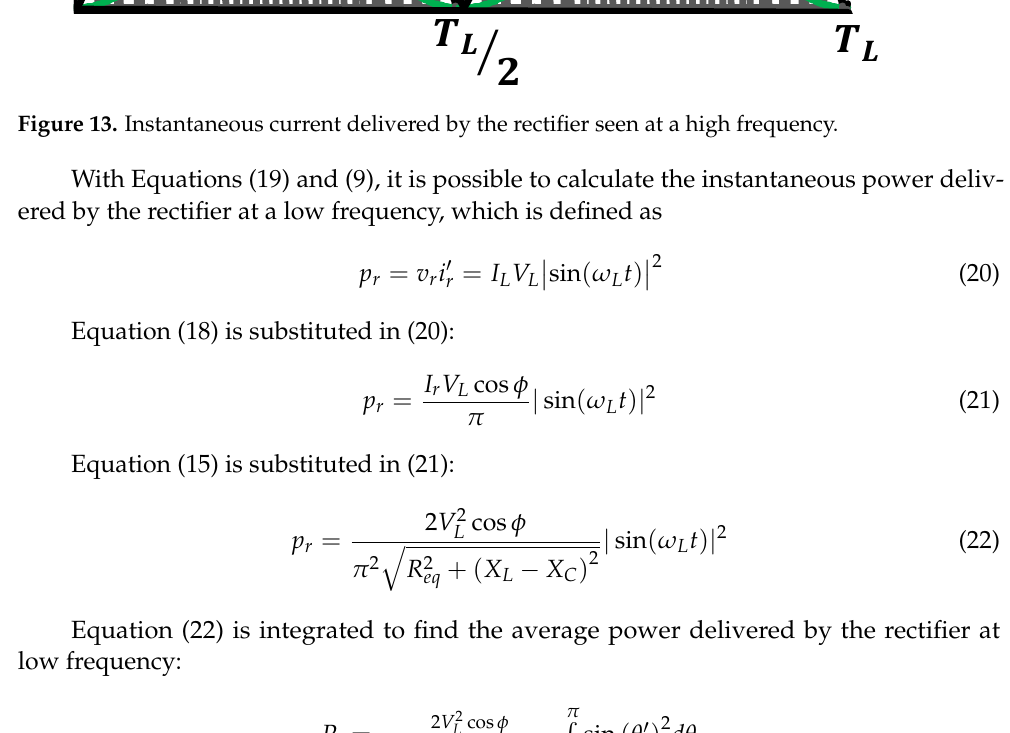
Equation (15) is substituted in (21):